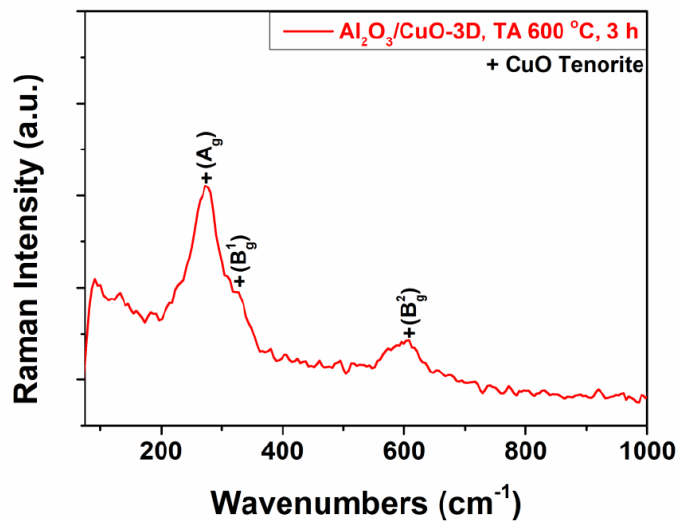
Figure 6. Room temperature Raman spectrum of the Al 2 O 3 /CuO-3D heterostructures after TA at 600 °C for 3 h in air.